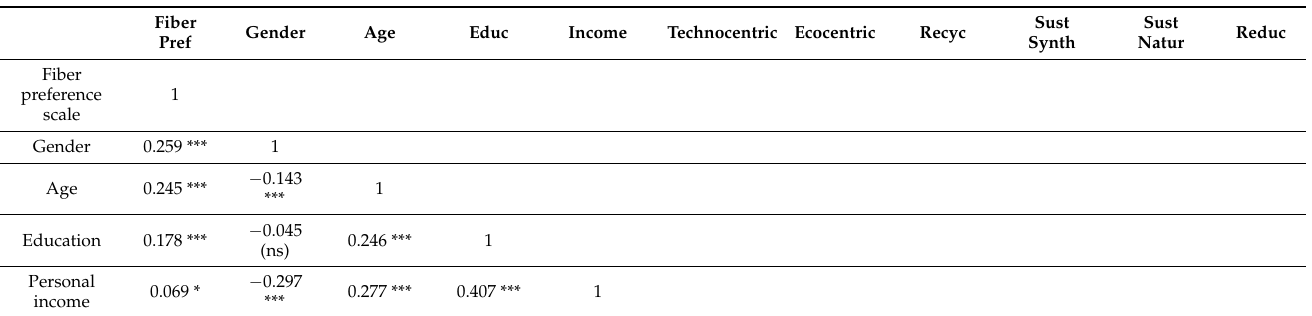
Table 3. Pearson correlations with a 2-tailed significance at the lower diagonal. Correlation